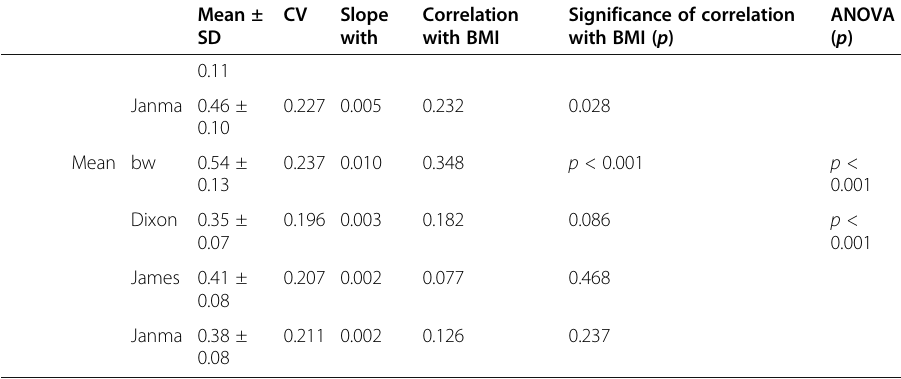
Table 3 Fitting results and dependent analysis of SUV vs. BMI for the FDG study ( n = 90) (Continued) Mean ± Slope SD